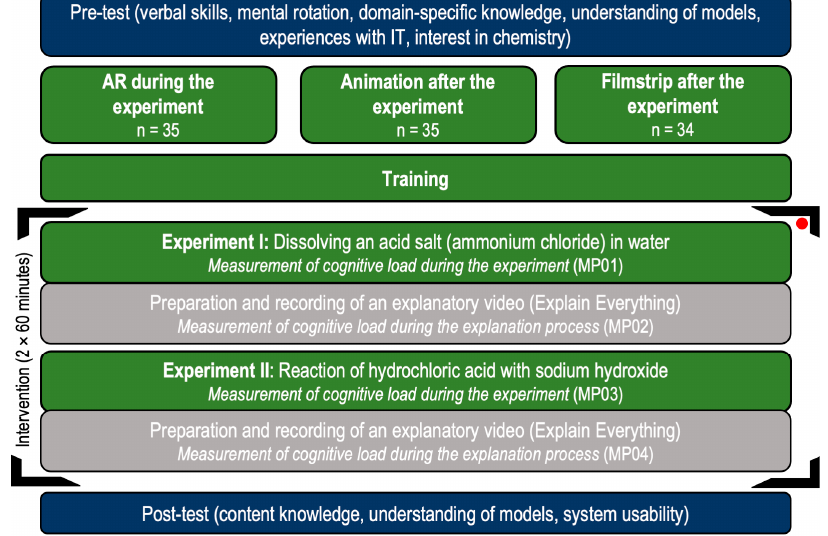
Figure 1. Study design. The instruments used are explained in the Instruments section.